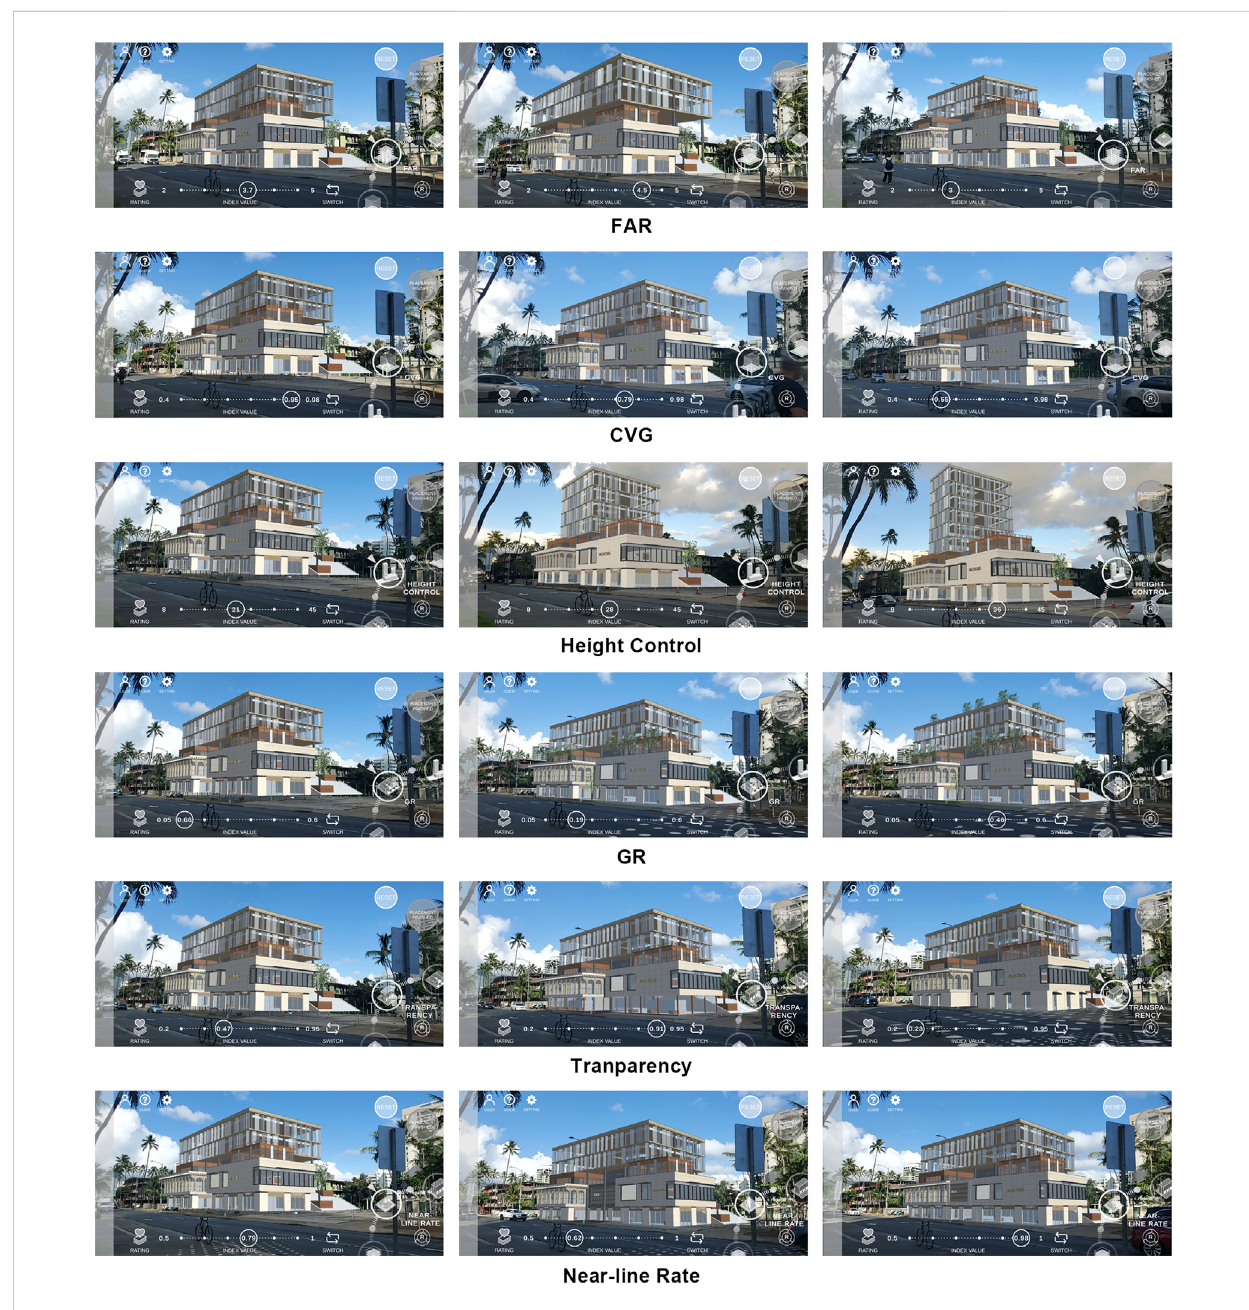
FIGURE 7 Changes in the designed models with the indicators ’ modi fi cation. Created with Unity Personal version and AR Foundation